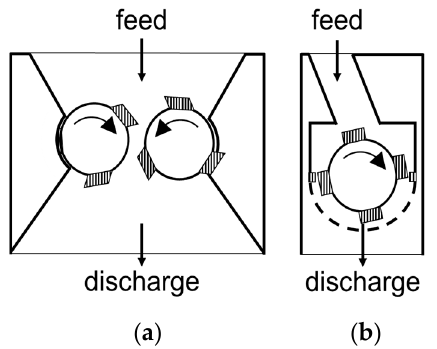
Figure 3. ( a ) schematic slow rotating, two shafts machine (RR/ RS); ( b ) schematic fast rotating, one shaft rotary shear (UG).